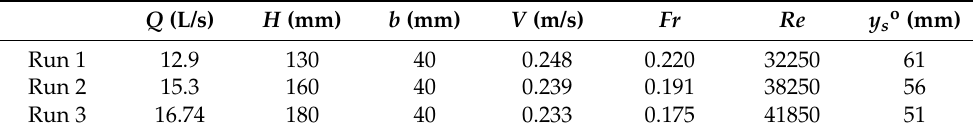
Table 3. Summary of the experimental